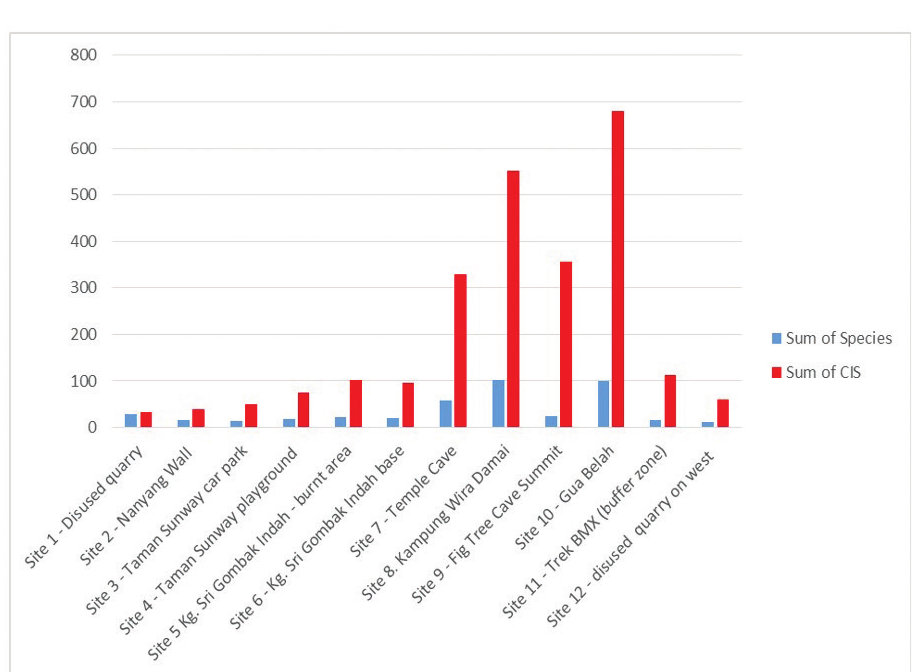
Figure 4. Conservation Importance Score (CIS) and species for all sites on Batu Caves. faces (microhabitat i). Their high score is a result of the combination of their threat- ened status, level of endemism and their being restricted to limestone. Even remnants of the buffer zone (microhabitat c) still also harbour plant